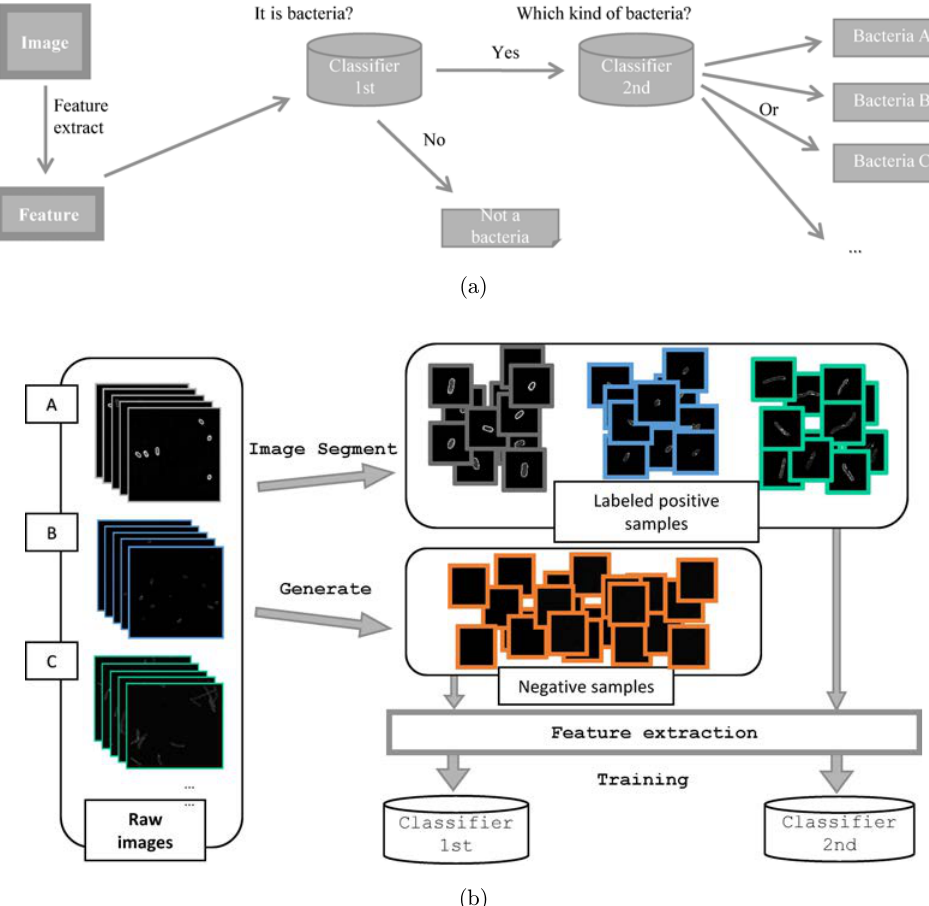
Fig. 5. Flowchart of strategy used for model classi¯cation and training. (a) The strategy of classi¯cation. (b) The pipeline of classi¯er